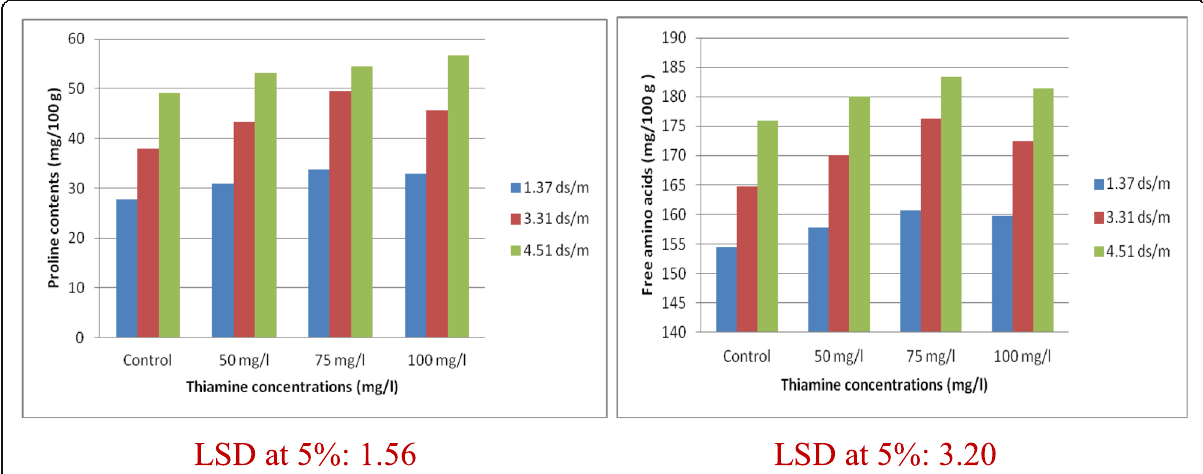
Fig. 6 Effect of the interaction between salinity levels and thiamine levels on proline and free amino acids (mg/100 g) contents of faba bean shoot at 60 days from sowing